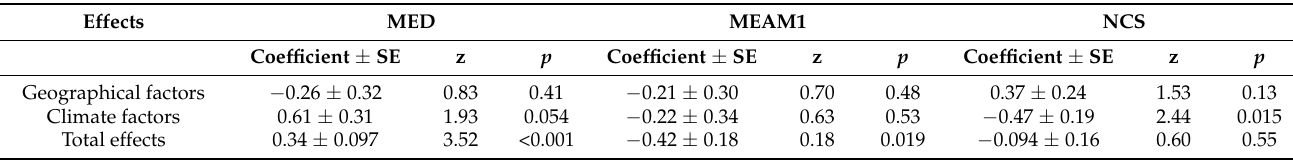
Table 2. Direct and indirect effects of environmental factors on the percentage of MED, MEAM1, and NCS estimated by the SEM model.